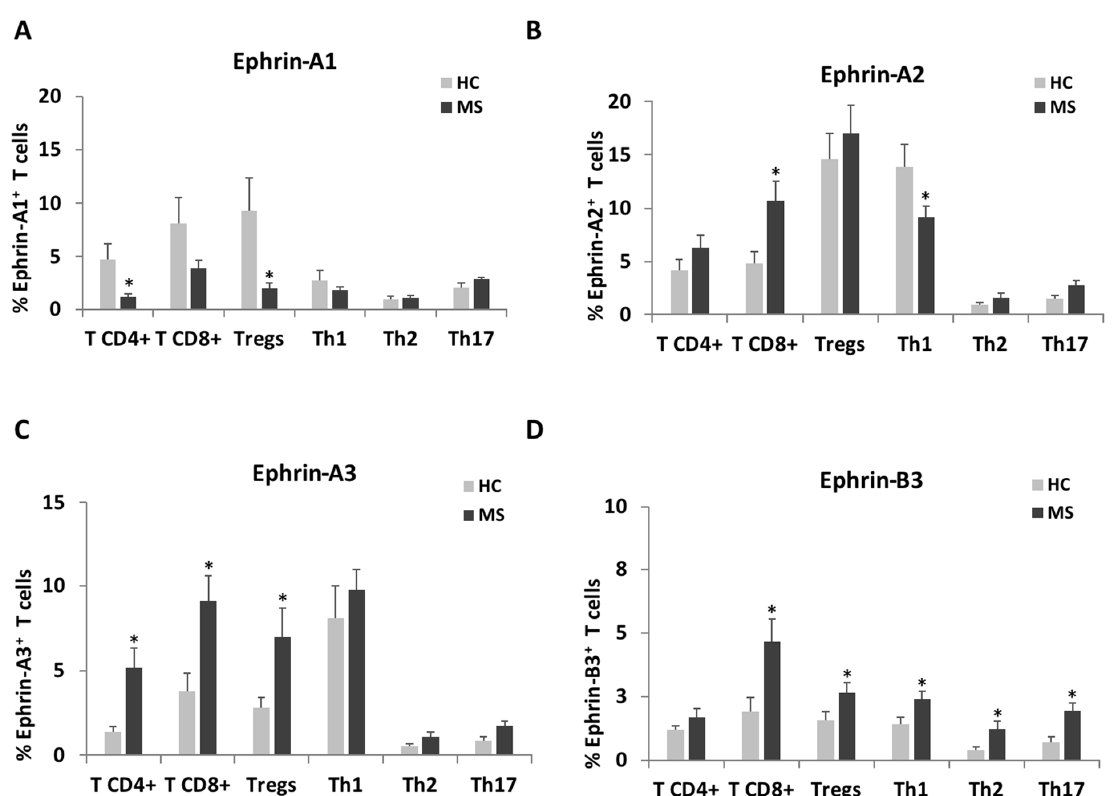
Figure 2. Ephrin expression levels on a subset of T cells of patients with RR-MS patients and of healthy controls. T cells of patients with RR-MS and HC were analyzed by flow cytometry for the percentages of expression of ephrin-A1 ( A ), ephrin-A2 ( B ), ephrin-A3 ( C ) and ephrin-B3 ( D ) on CD4 + T cells, CD8 + T cells, Tregs, Th1, Th2 and Th17 cells. * p < 0.05. Table 3. Ephrin mean fluorescence intensity on different T cell subtypes.